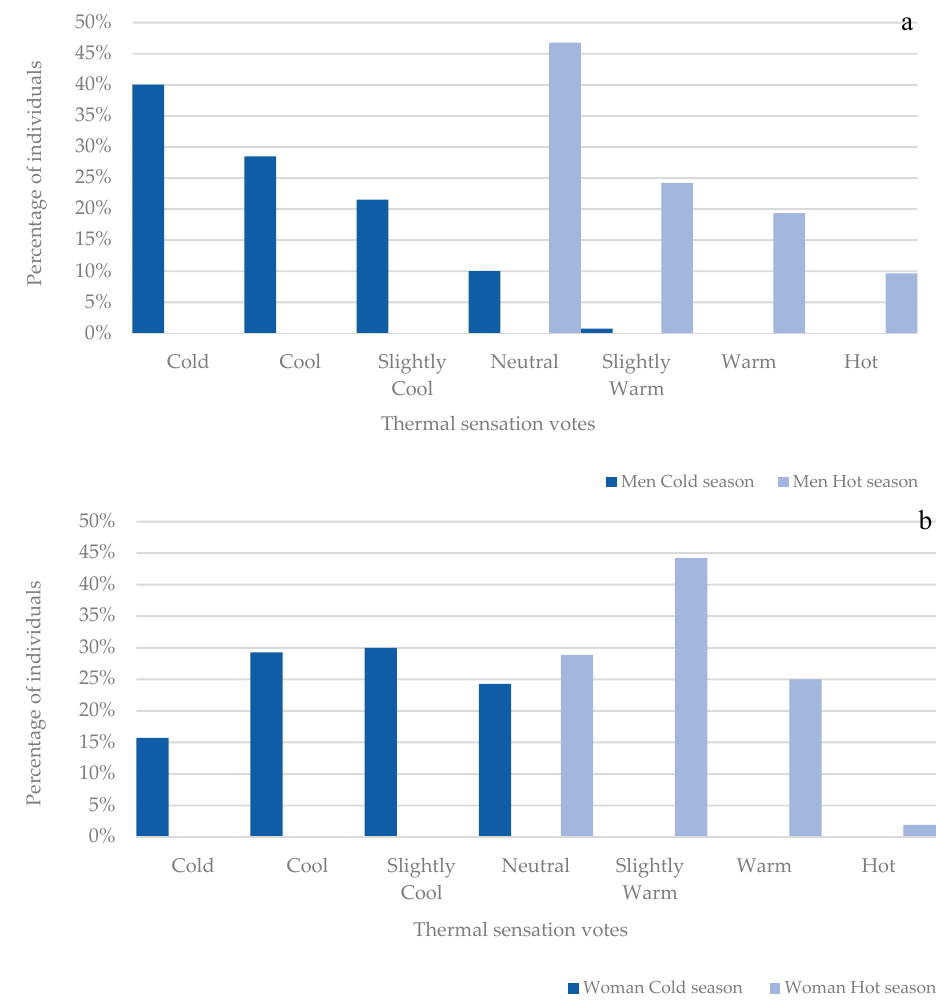
Figure 4. Percentages of thermal sensation votes for both men and women during cold and hot seasons separately. In the hot season, the highest TSV percentage was neutral (46.7%), and in the cold season, the highest TSV percentage was cold (40%) for male interviewees ( a ). The highest TSV percentage in the hot season was slightly warm (44.2%), and in the cold season, the highest TSV percentage was slightly cool (30%) for women interviewees ( b ) The overall percentage of acceptable votes (TSV = ±1 defines thermal acceptability, and TSV ≤ –2 or TSV ≥ 2 defines unacceptable conditions) in the cold season was 43.2% (54.2% women and 32.3% men), and in the hot season was 72% (73% women and 70.9% men), which shows evidence of thermal adaptation.